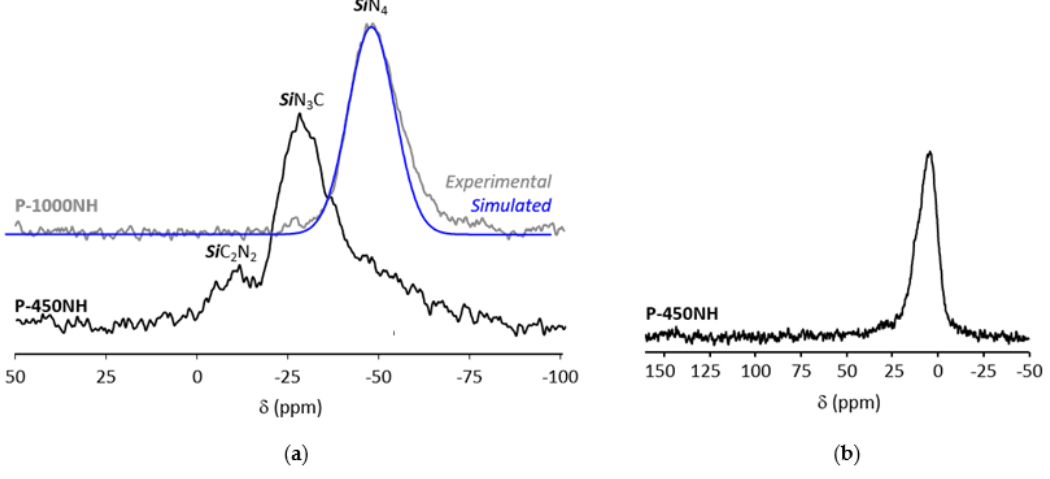
Figure 5. Experimental 29 Si MAS NMR ( a ) and 13 C CP MAS NMR ( b ) spectra recorded for the pyrolysis intermediates derived from PVMSZTi 2.5 at 7 T.